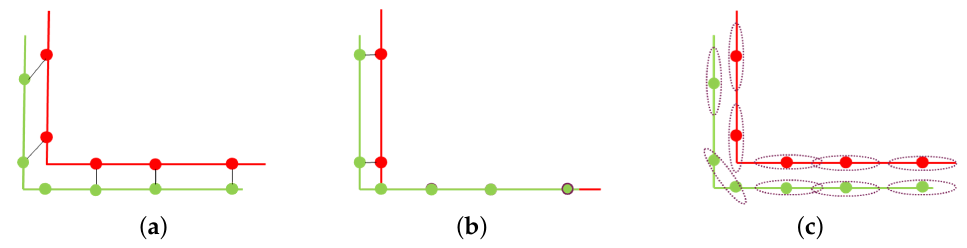
Figure 3. Illustration of point-to-point and plane-to-plane strategies. ( a ) Point-to-point strategy; ( b ) point-to-point is easily trapped into local optima; ( c ) plane-to-plane